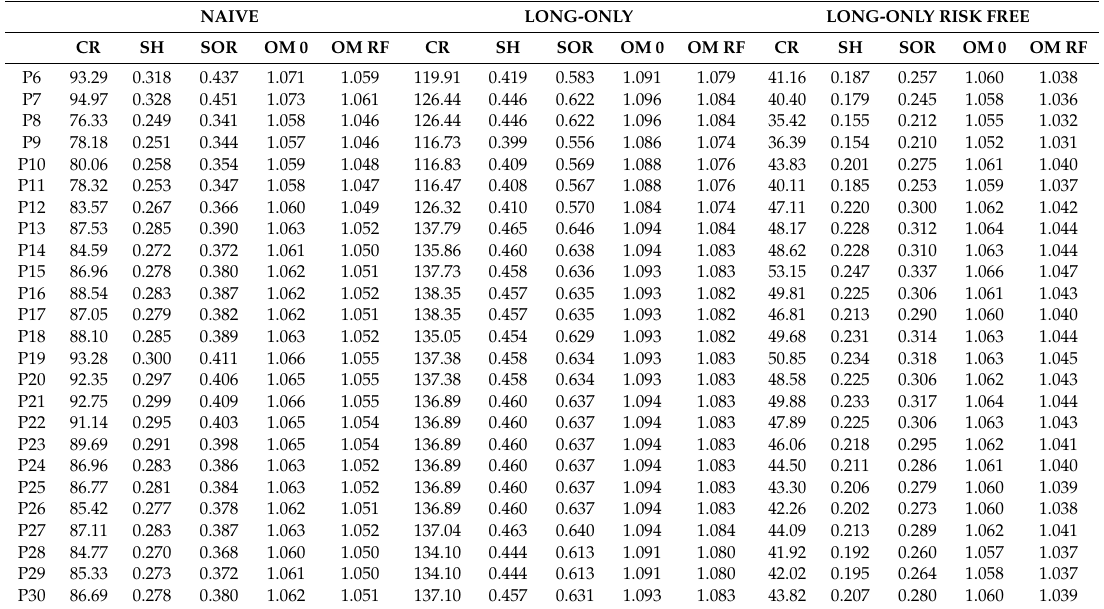
Table 5. Performance from responsible portfolios using a 5-year rolling